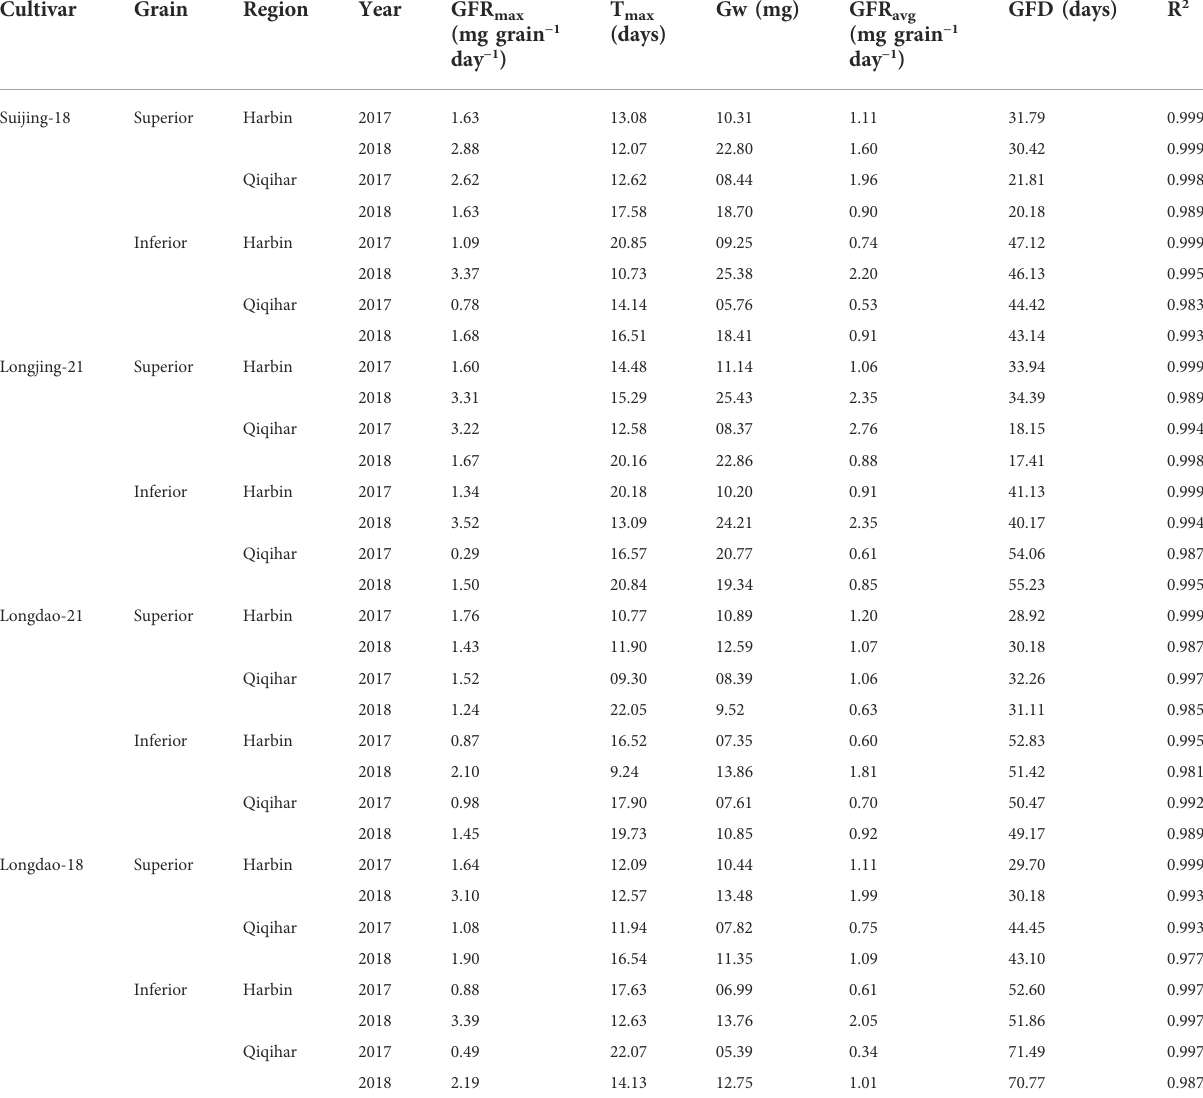
TABLE3Comparisonsofthericegrain- fi llingcharacteristics